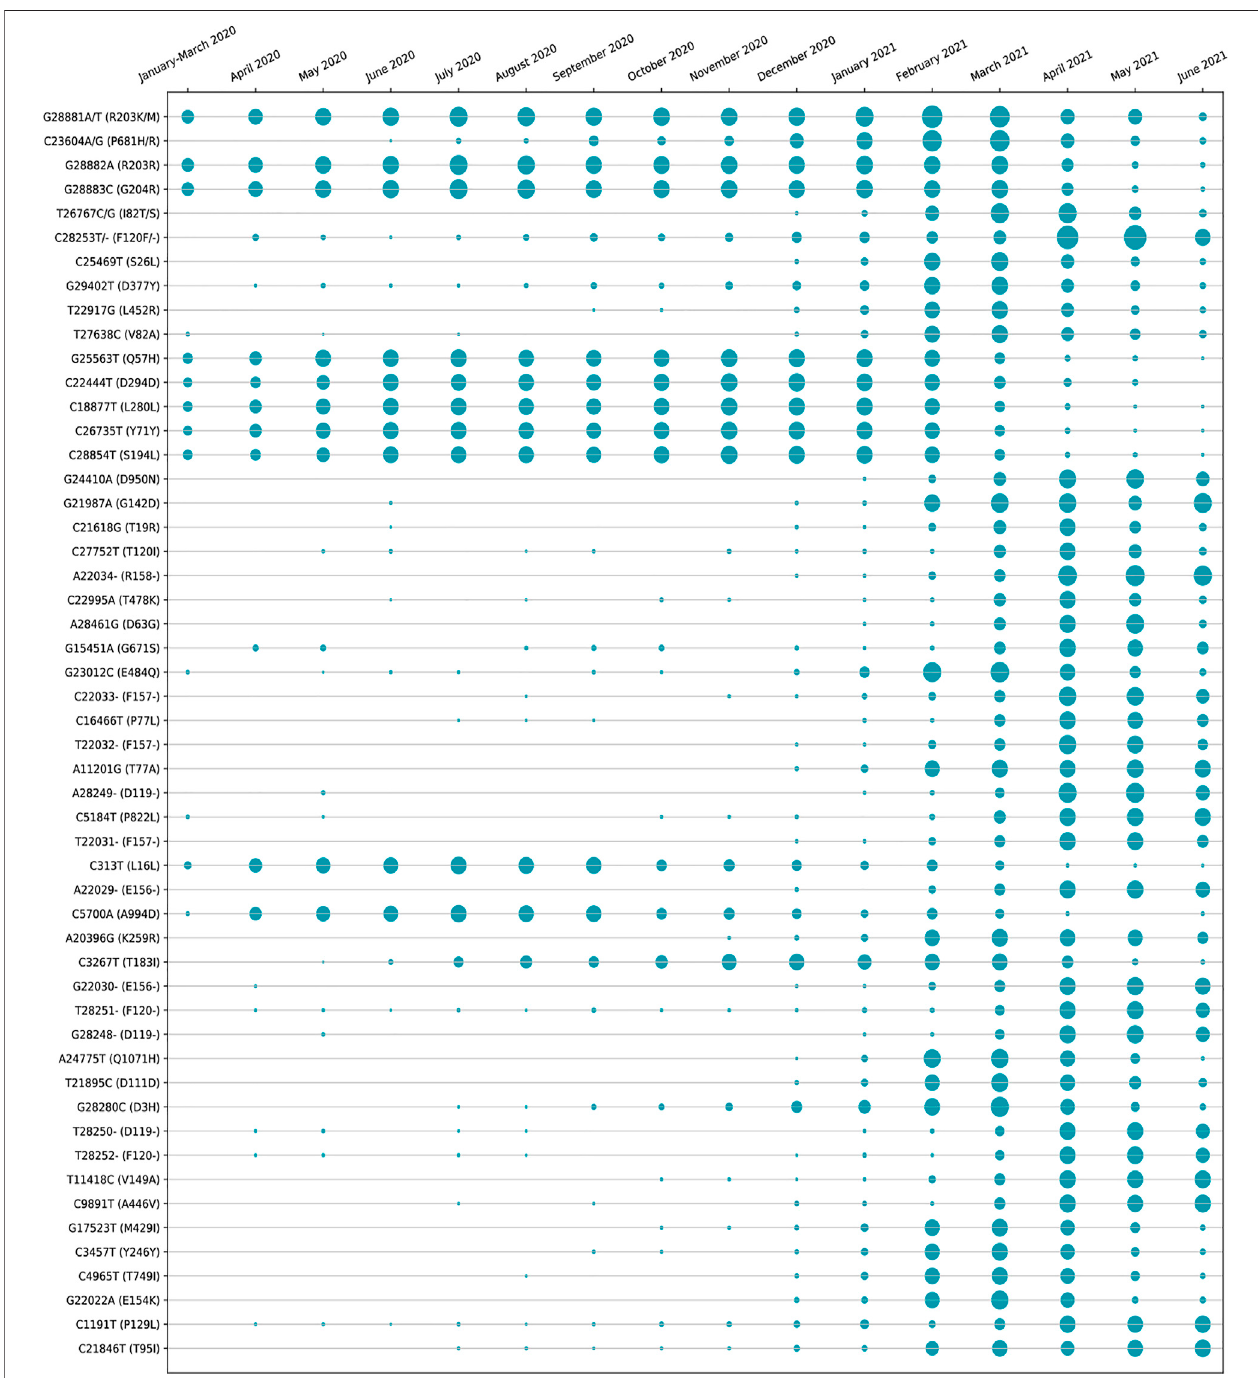
FIGURE 6 | Month-wise evolution of Indian SARS-CoV-2 genomes based on entropy.